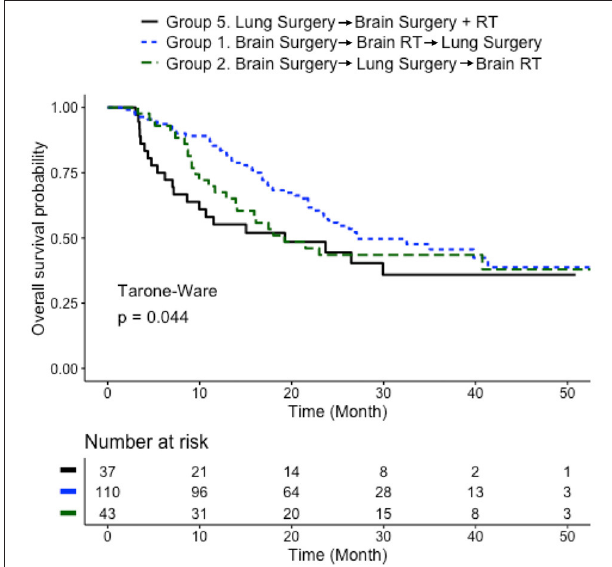
FIGURE 4 | Comparison of sequences of three local treatments. Survival curves for patients who received three local treatments in different sequences (blue: brain surgery followed by brain RT and then lung surgery; green: brain surgery followed by lung surgery and then brain RT; black: lung surgery followed brain multitherapy). Median survival time: 27.1 months for Group 1; 19.2 months for Group 2; 19.2 months for Group 5. Three group comparison: Tarone-Ware test p < 0.05. Pair-wise Tarone-Ware test: p < 0.05 for Group 1 vs. Group 5; p = 0.14 for Group 1 vs. Group 2; p = 0.33 for Group 2 vs. Group 5. Number of patients with available survival data: n = 110 in Group 1; n = 43 in Group 2; n = 37 in Group